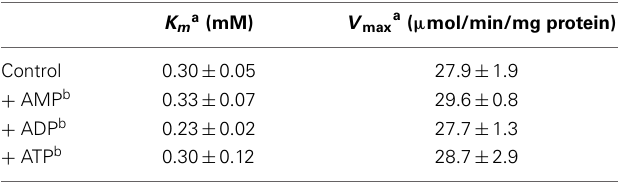
Table 1 | Effects of adenylates on kinetic parameters of Arabidopsis IDH recombinant protein.